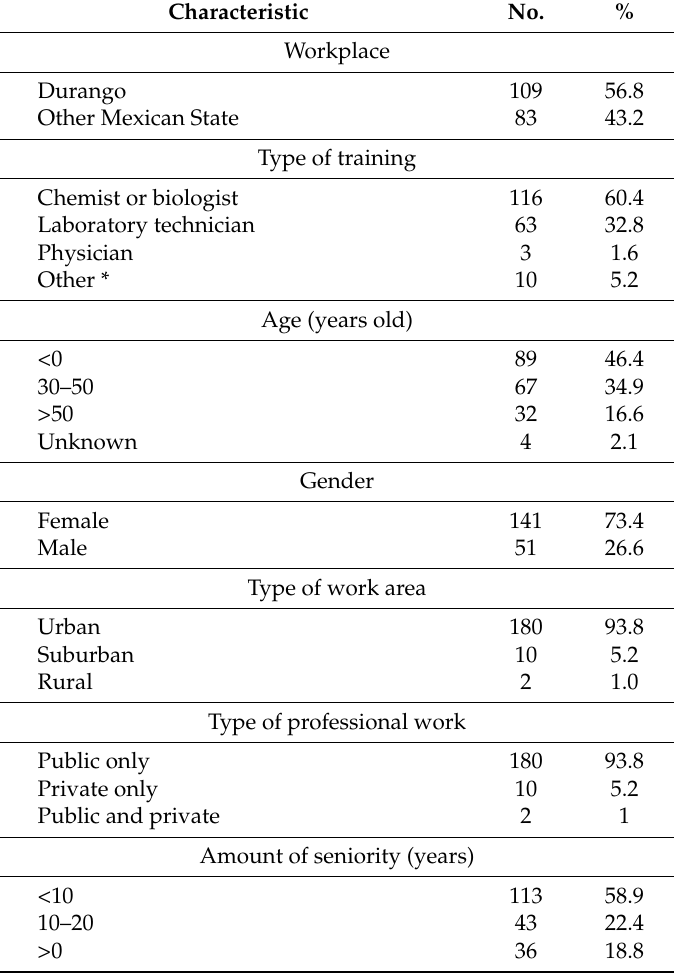
Table 1. General characteristics of the population studied.